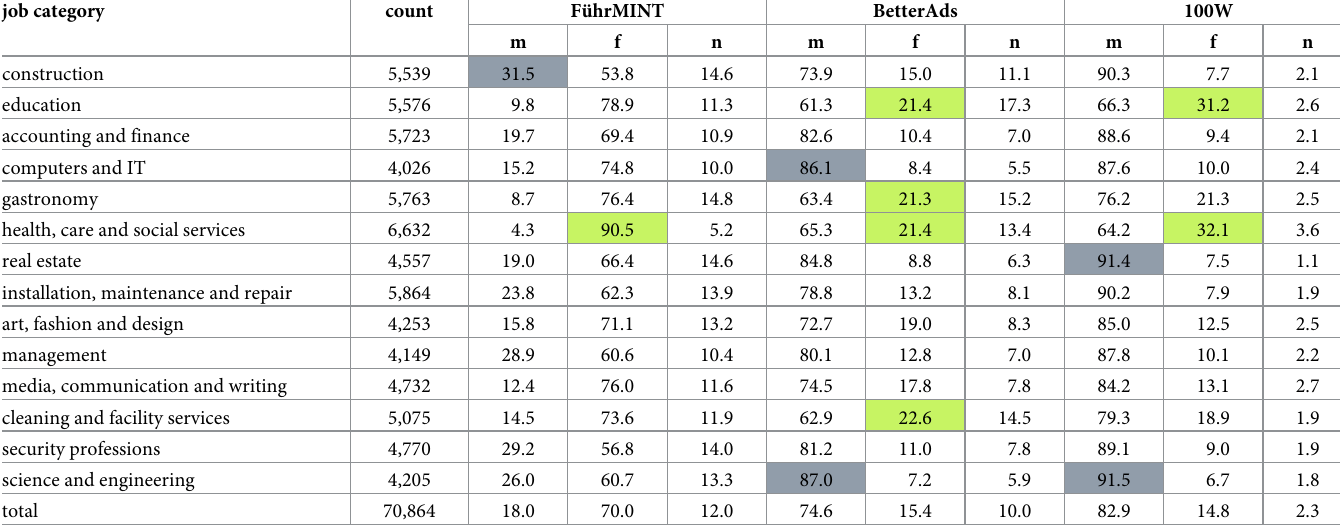
Table 8. Proportions of job ads per job category classified as male-connoted (m), female-connoted (f), or neutral (n), using Google Jobs as the underlying data. The color-highlighted cells correspond to job categories with the statistically significant highest proportions per tool and gender category (green for female-connoted and grey for